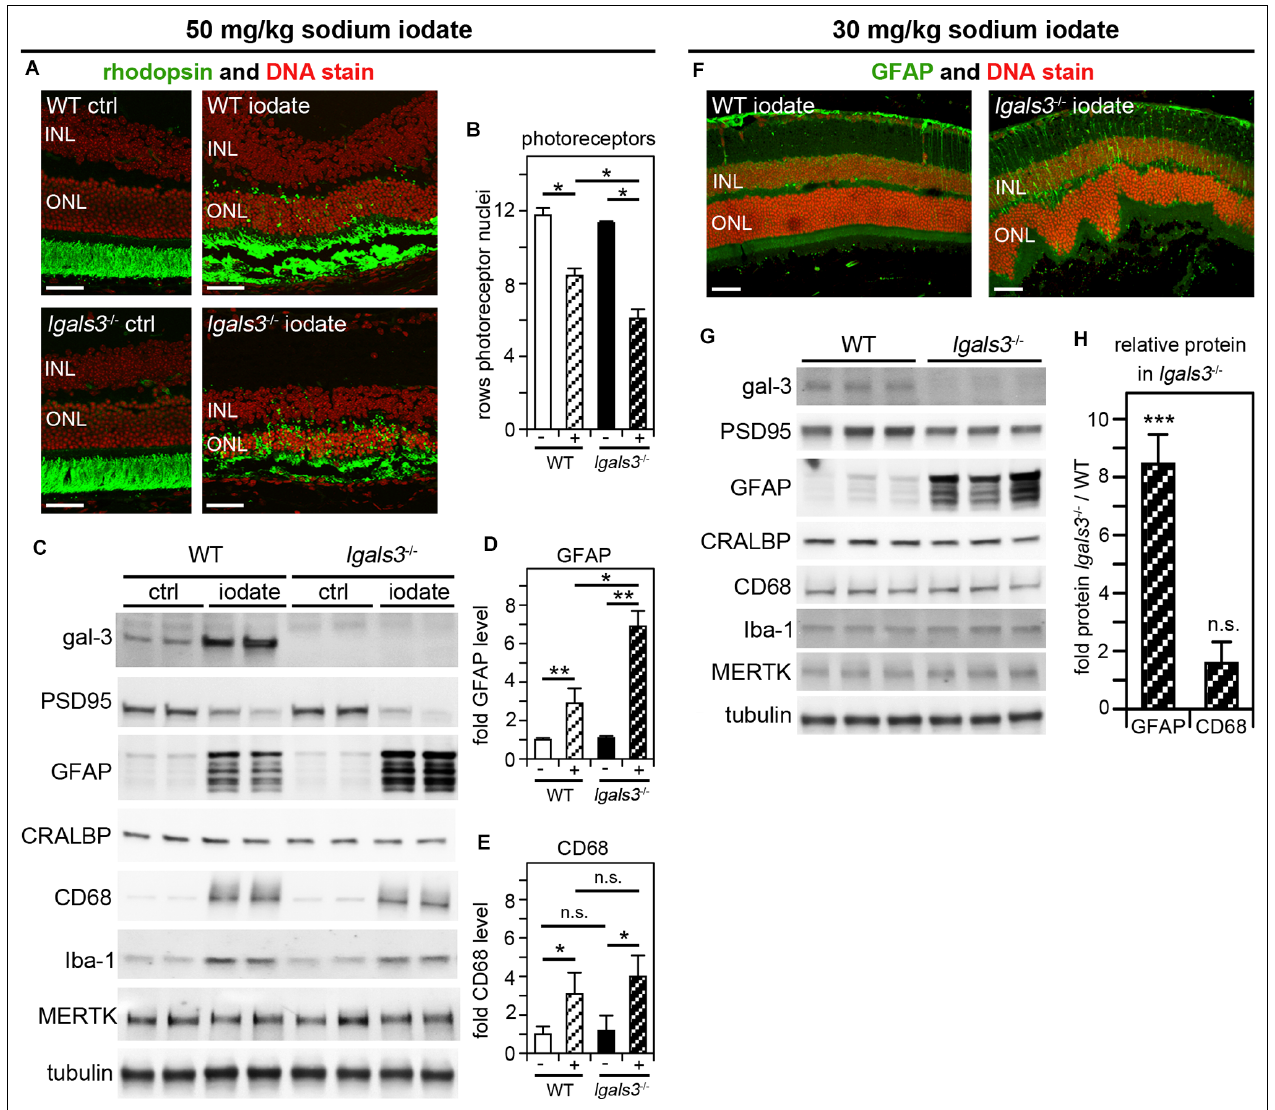
FIGURE 6 | Galectin-3 deficiency increases sensitivity to sodium iodate-induced retinal damage, which involves galectin-3 upregulation in WT retina. At P28, WT and lgals3 -/- mice received injections of 50 mg/kg sodium iodate or control solvent alone (ctrl) (AvE) or 30 mg/kg sodium iodate (F–H) . Five days after sodium iodate administration eyeballs were either processed for sectioning and immunofluorescence microscopy (A,F) or dissected to yield isolated neural retina samples for immunoblotting (C,G) . (A) Representative fields show rhodopsin photoreceptor outer segment marker (green) and nuclei counterstain (red). Scale bars: 40 µ m. Control treatment did not affect the retina regardless of genotype (panels ctrl). Both iodate-treated WT and lgals3 -/- retina (panels iodate) showed outer retina disruption. (B) Quantification of rows of photoreceptor nuclei revealed more pronounced photoreceptor loss in iodate-treated lgals3 -/- retina than in WT retina (compare striped bars). Bars compare rows of photoreceptor by genotype and treatment, with white bars indicating WT, black bars indicating lgals3 -/- , and striped bars indicating sodium iodate treatment. Bars show mean ± s. d.; n = 3 biological samples from three different mice. (C) A representative immunoblot is shown comparing two neural retina samples from two different mice for each genotype and treatment as indicated. Probes as indicated, were applied to test galectin-3 and MERTK expression, PSD95 as a neural marker, as well as Müller and microglia markers as for Figure 5 . Tubulin was used as total sample loading control. (D,E) Protein levels were quantified from blots as in (C) to yield bar graphs. (D) GFAP quantification relative to CRALBP, a protein primarily expressed by Müller cells in the neural retina, revealed increased Müller glia activation in lgals3 -/- mice as compared to WT mice if both received sodium iodate treatment. (E) CD68 quantification relative to Iba-1, a microglia marker, showed that microglia activation upon sodium iodate treatment did not differ between WT and lgals3 -/- mice. For (B,D,E) differences among tissues was assessed using ANOVA; * indicates p < 0.05; n. s. indicates no significant difference ( p > 0.05). (F) Following low dose sodium iodate treatment, representative immunofluorescence microscopy fields show obvious GFAP Müller activation marker and outer retina disruption only in lgals3 -/- retina. Nuclei are counterstained in red. Scale bars: 40 µ m. Panel (G) shows immunoblot membrane comparison of photoreceptor, Müller, and microglia marker proteins (as in B ) from three neural retina samples from three different mice for each treatment. Quantification of relative protein levels in lgals3 -/- neural retina compared to WT neural revealed a significant increase in GFAP—but not in CD68—indicating specifically Müller glia activation in mice lacking galectin-3 treated with low dose sodium iodate. (H) Bars show mean ± s. d.; n = 3 biological samples from three different mice. The Student’s t-test was used to establish differences between lgals3 -/- and WT protein content; ** indicates p < 0.01; *** indicates p < 0.005; n. s. indicates no significant difference ( p > 0.05).